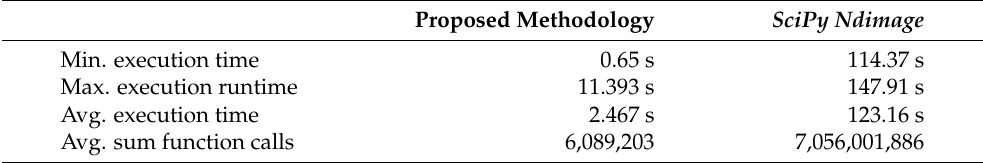
Figure 9. Sensitivity analysis on the proposed methodology. Displayed are the effects of the three parameters, irradiation cut-off, neighbourhood edge length and M OORE neighbourhood threshold value. Table 3. Profiling results for the proposed methodology and the image filtering module ‘ndimage’ of SciPy